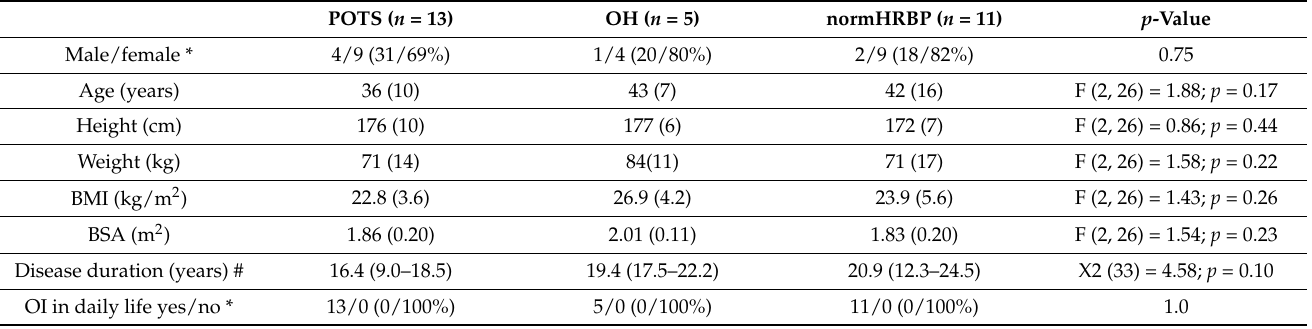
Table 1. Clinical characteristics of long-haul COVID-19 patients with POTS, with OH, and with a normal heart rate and blood pressure (normHRBP) during the tilt test.